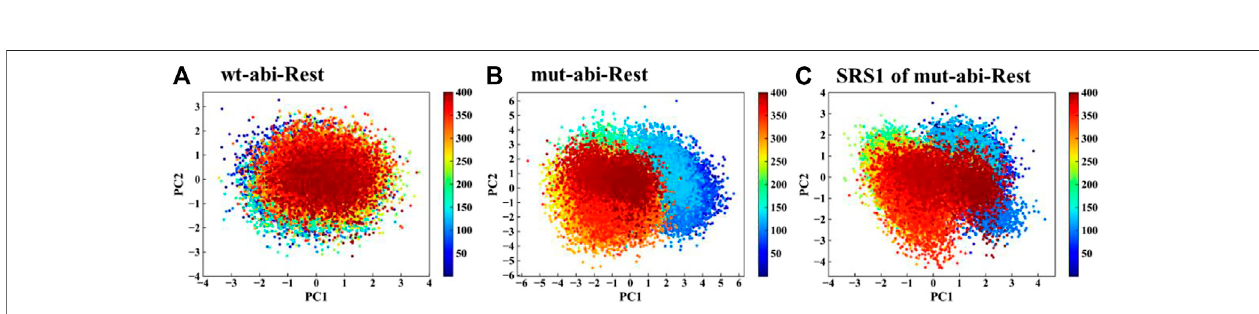
FIGURE 3 | PCA of pocket residues of systems wt-abi-Rest (A) , mut-abi-Rest (B) , and SRS1 residues of mut-abi-Rest system (C) .